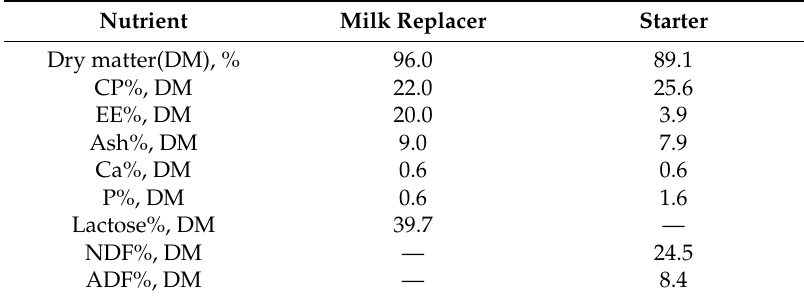
Table 1. Nutrient composition of milk replacer and